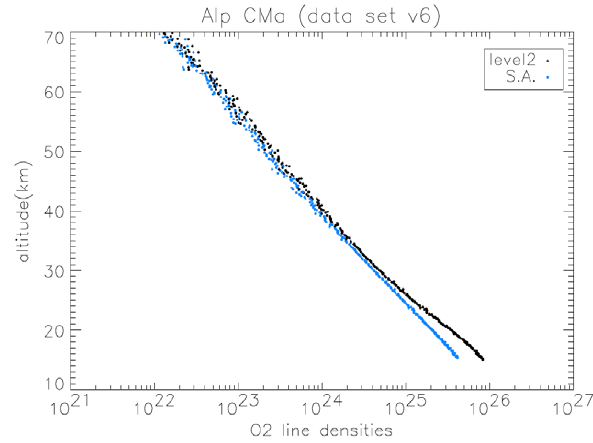
Fig.40. Comparison of oxygen line densities retrieved from GOMOS 760 nm O 2 band transmission measurements for 6 occultations of the star Sirius (Alpha Canis Major). Black points: with models Fig. 40. Comparison of oxygen line densities retrieved computed with HITRAN 1996 data base. Blue points: with HITRAN 2000 data base. There is an from GOMOS 760nm O 2 band transmission measurements for increasing difference with decreasing altitude. 6occultations of the star Sirius (Alpha Canis Major). Black points: with models computed with HITRAN 1996 data base. Blue points: Fig. 39. Comparison of H 2 O vertical profiles obtained by HALOE (blue line) and GOMOS (red lines). Fig. 39. Comparison of H 2 O vertical profiles obtained by HALOE with HITRAN 2000 data base. There is an increasing difference In black and upper scale: the number of GOMOS measurements in each altitude bin obtained with the (blue line) and GOMOS (red lines). In black and upper scale: the with decreasing occultation of star Gamma Gruis. The thick red line is the median value, and the thin lines are the upper number of GOMOS measurements in each altitude bin obtained and lower quartile of the distribution in each bin (from Bertaux et al., 2009). with the occultation of star Gamma Gruis. The thick red line is the median value, and the thin lines are the upper and lower quartile of the distribution in each bin (from Bertaux et al., 2009).